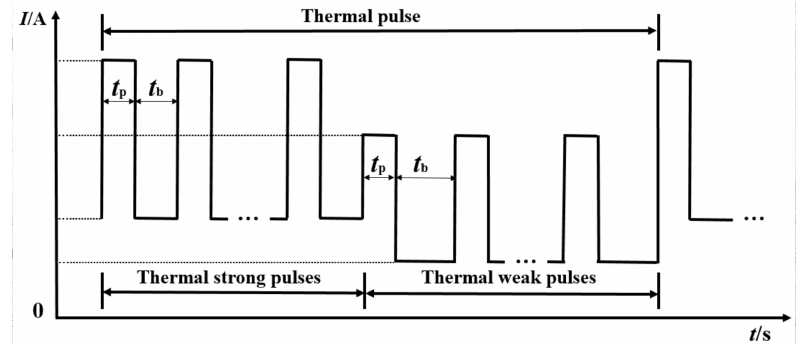
Figure 1. The current waveform of double pulsed gas metal arc welding